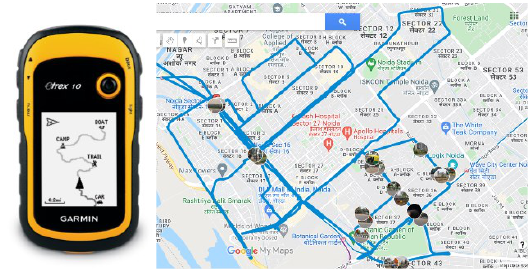
Figure 3 . Garmin Etrex 10 GPS device and Tracked GPS routes and clicked photos of the Pedestrian